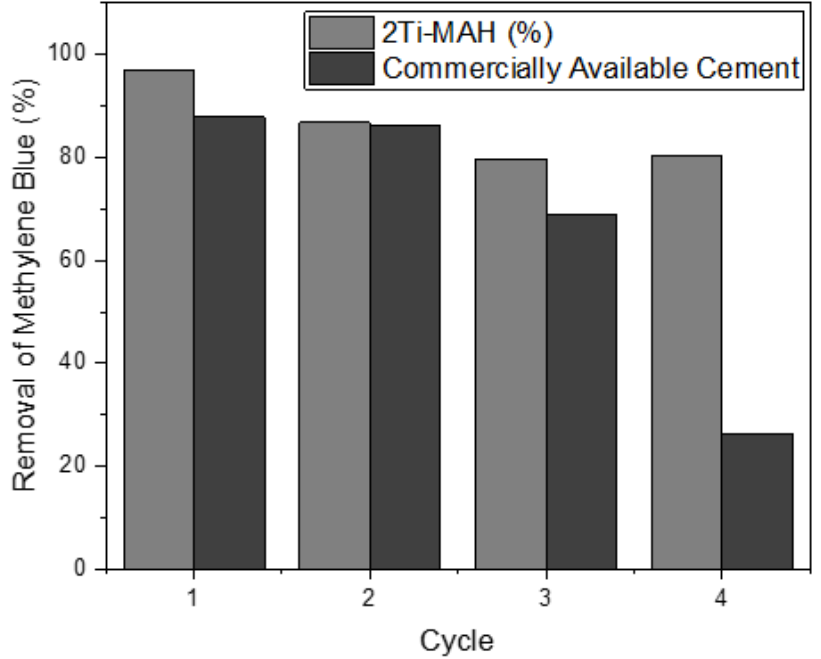
Figure 15. Absorbance over cycles comparison of 2Ti-MAH versus commercially available photocatalytic cement.